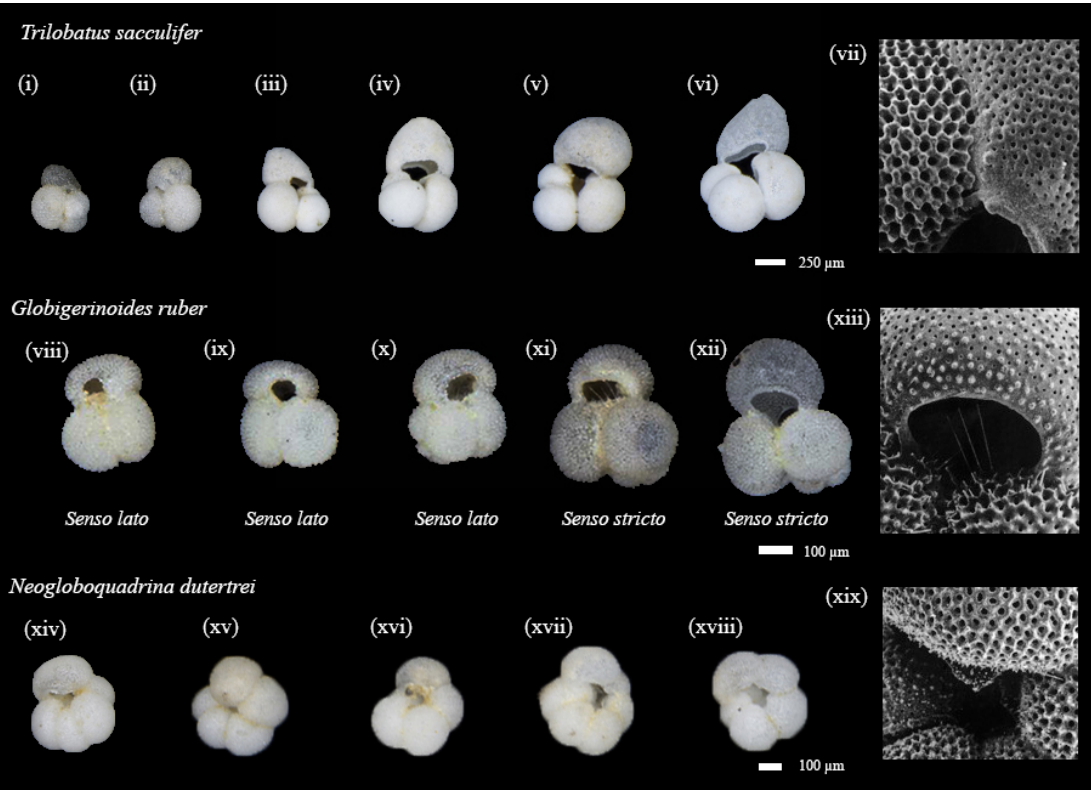
Figure 2. Representatives of species used within this study. Light microscope from core top location and scanning electron microscope (SEM) images used to highlight particular features were collected using plankton tows and plankton pumps from the Arabian Sea during the NIOP cruise (Peeters, 2000; Peeters et al., 2002). Note that this final sac-like chamber of Trilobatus sacculifer has various unique morphologies, including a thinner walled variety giving the specimen’s F chamber a translucent quality (similar to i and vi). The species Globigerinoides ruber has two morphotypes referred to as (xi–xii) senso stricto (s.s.) and (viii–x) senso lato (s.l.), whilst Neogloboquadrina dutertrei is distinguished from other species of Neogloboquanids by the presence of a